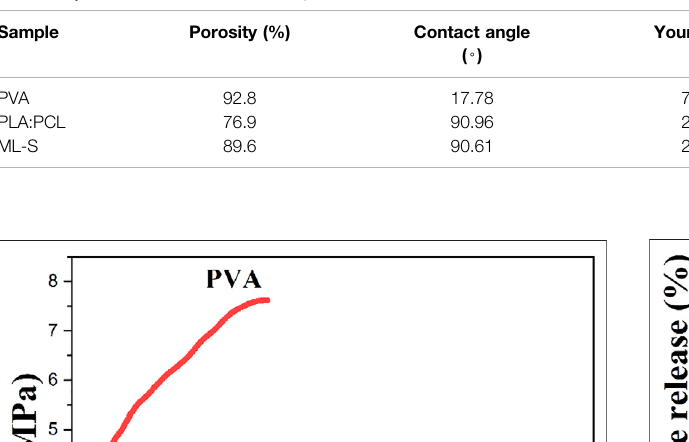
TABLE 3 | Characterization of each sample.